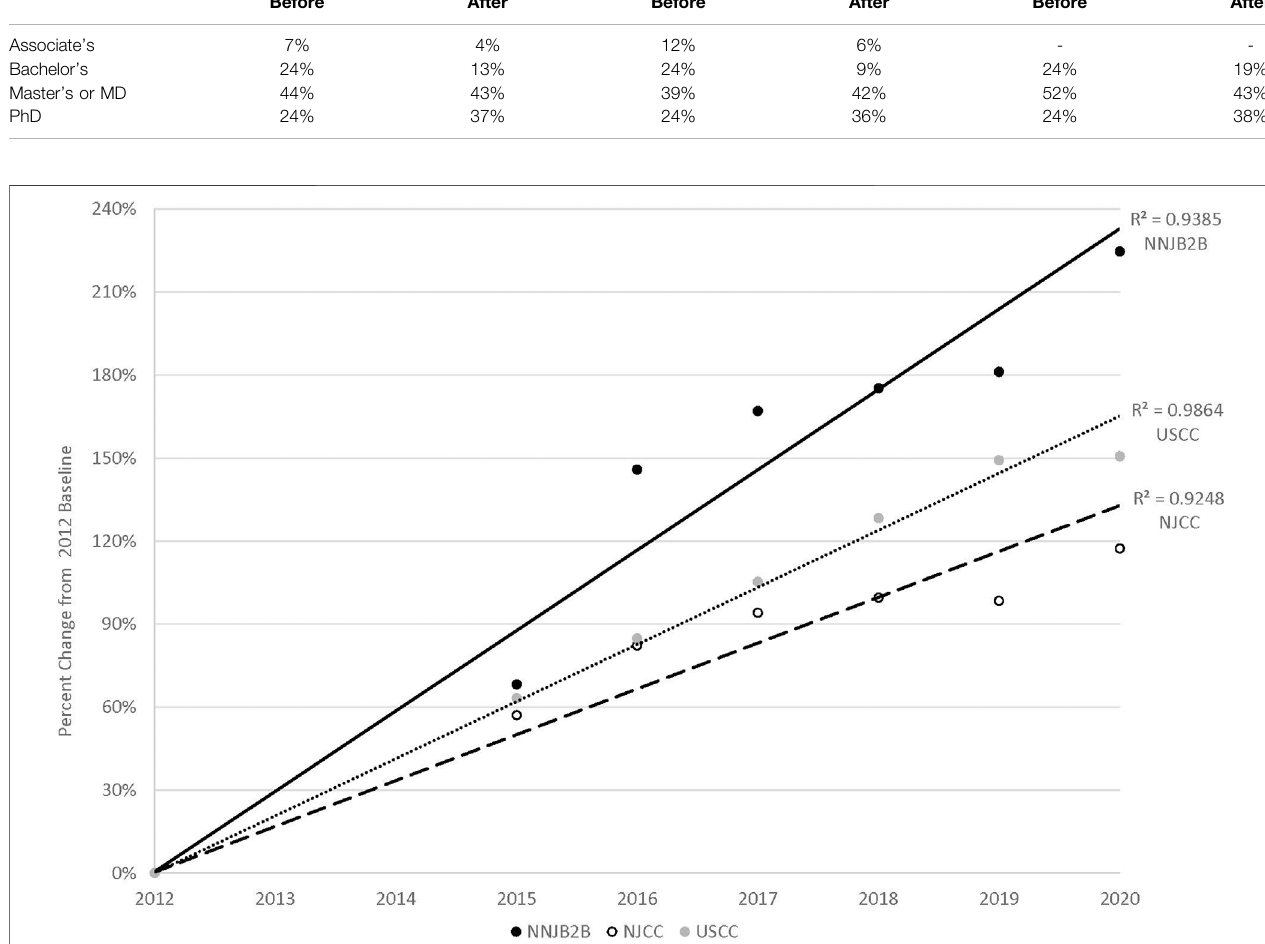
FIGURE 2 | Associates Degrees awarded to URM students in STEM fi elds at NNJB2B and at all community collegues in New Jersey (NJCC, n (cid:1) 19) and in the United States (USCC, n (cid:1) 924) as reported to IPEDS. Data shown as percent increase from the 2012 baseline.